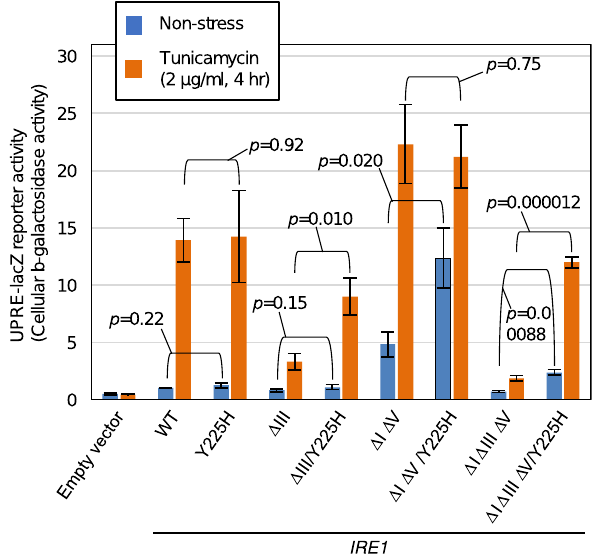
Figure 2. Effect of the Y225H mutation on the UPR inducibility of Ire1 mutants. KMY1015 cells ( ire1Δ ) bearing the UPRE-lacZ reporter plasmid, pCZY1, were transformed with the IRE1 plasmid, pRS315-IRE1-HA (wild-type: WT), or with that carrying the indicated mutations (or with the empty vector, pRS315), and were grown at 30 °C in SD medium. For ER stress induction, we added tunicamycin (2 µg/mL) into the cultures, which were further cultured for 4 h. The cultures were then subjected to the measurement of cellular β-galactosidase activity, and the resulting values are normalized against that of wild-type (WT) IRE1 cells, which is set at 1.0.